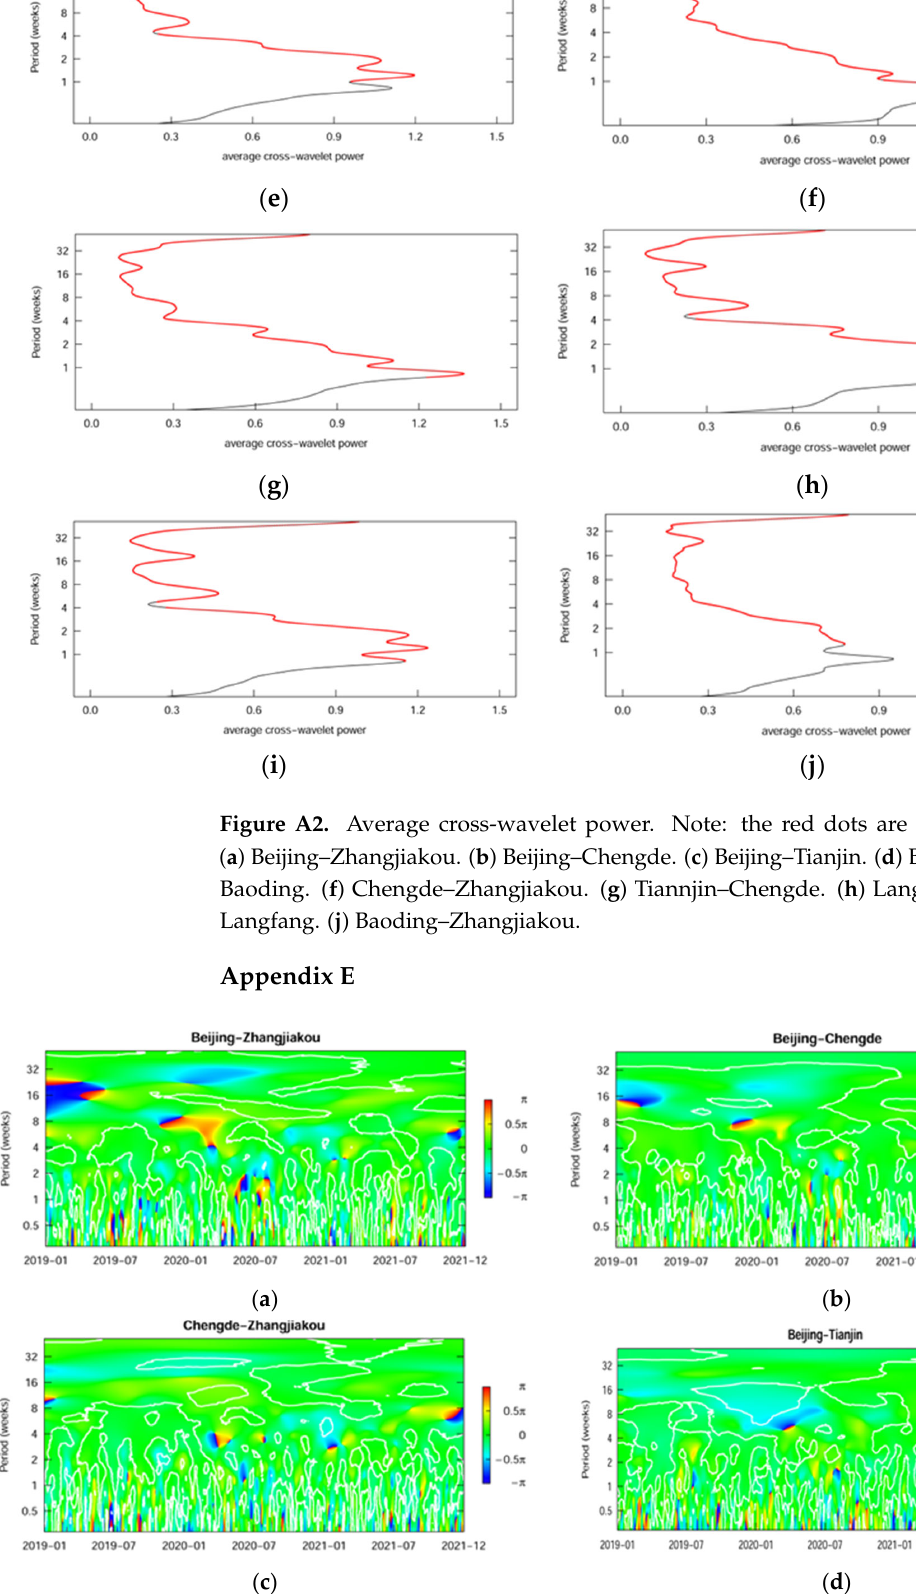
( j ) Figure A3. The phase difference. Note: The horizontal axis is time and the vertical axis is the peri ‐ odicity length in weeks. The phase difference ranges from blue ( ‐π ) to red ( π ), which represents the characteristics of phase difference (see Equation (5)). The white contour marks the 5% significance